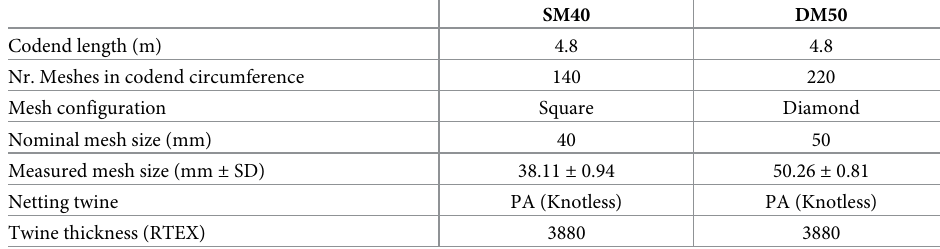
Table 1. Technical features of the two codends tested. SM40: 40 mm square mesh codend; DM50: 50 mm diamond mesh